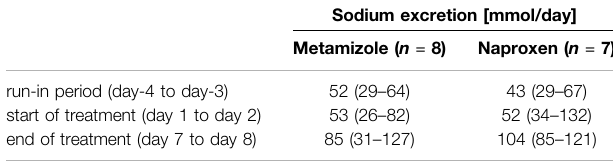
TABLE 1 | Urinary sodium excretion in 24 h urine